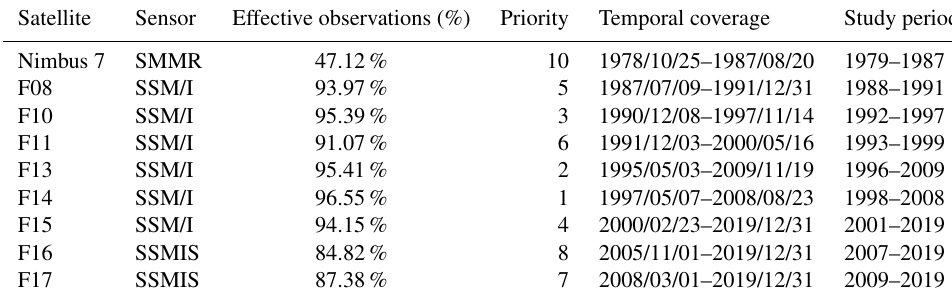
Table 2. Percentage of effective observations and the sequence for different satellites.